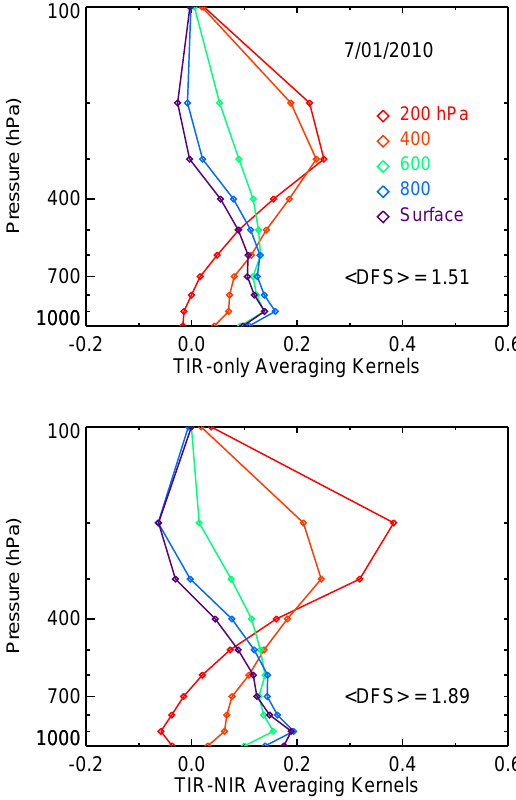
Figure 3. Comparison of mean retrieval averaging kernels for the MOPITT Version 6 TIR-only (top panel) and TIR-NIR (bottom panel) products for the western Amazon Basin on 17 September